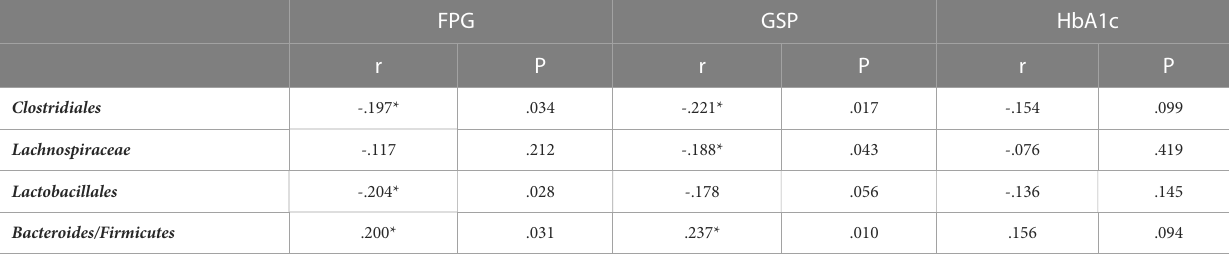
TABLE 7 Correlation between gut microbiota abundance and glucose metabolism indicators.